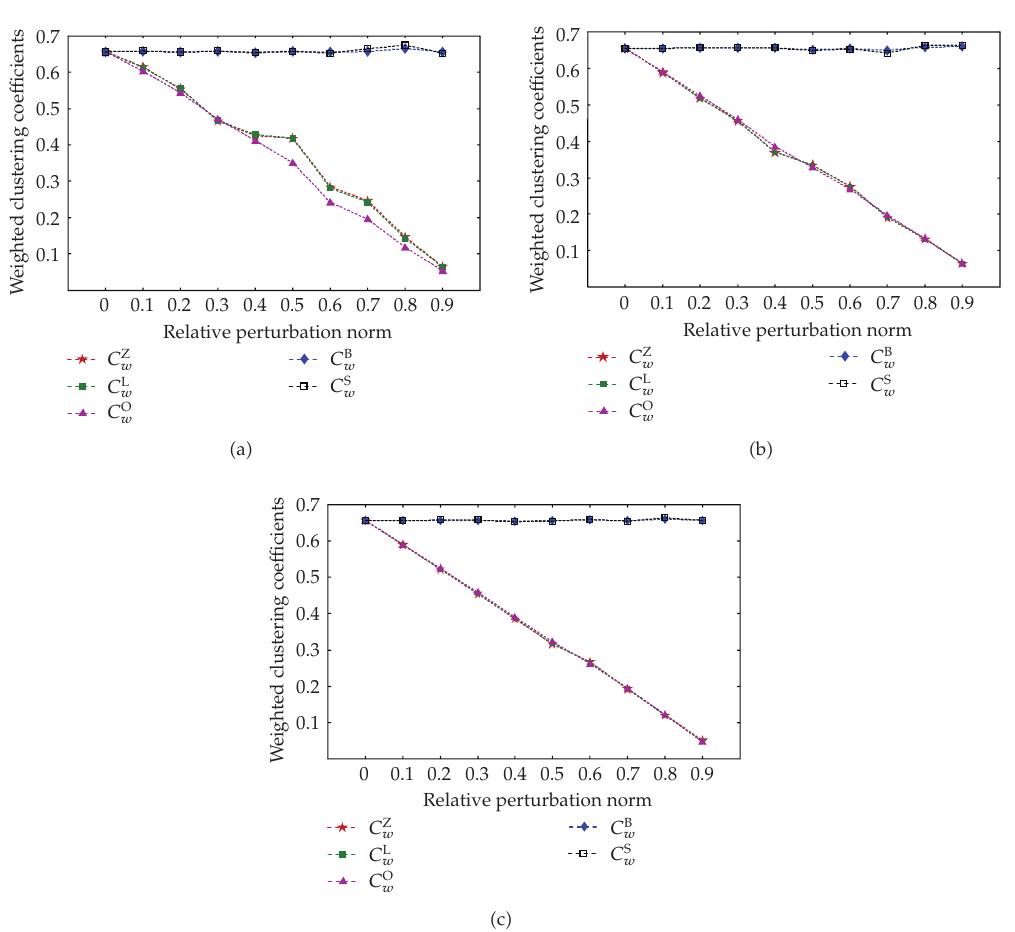
(cid:7) (cid:2) (cid:8) , Lopez- w,i (cid:7) (cid:6) (cid:8) , in terms of w,i